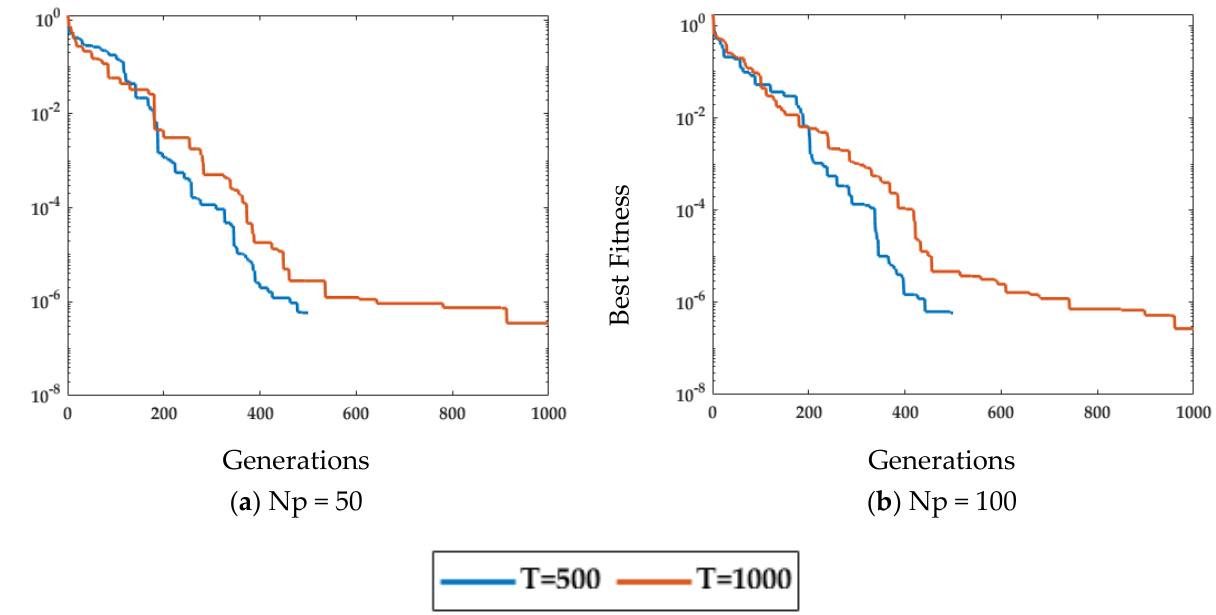
Figure 3. Fitness plots for MPA w.r.t generation variations for case study 1.